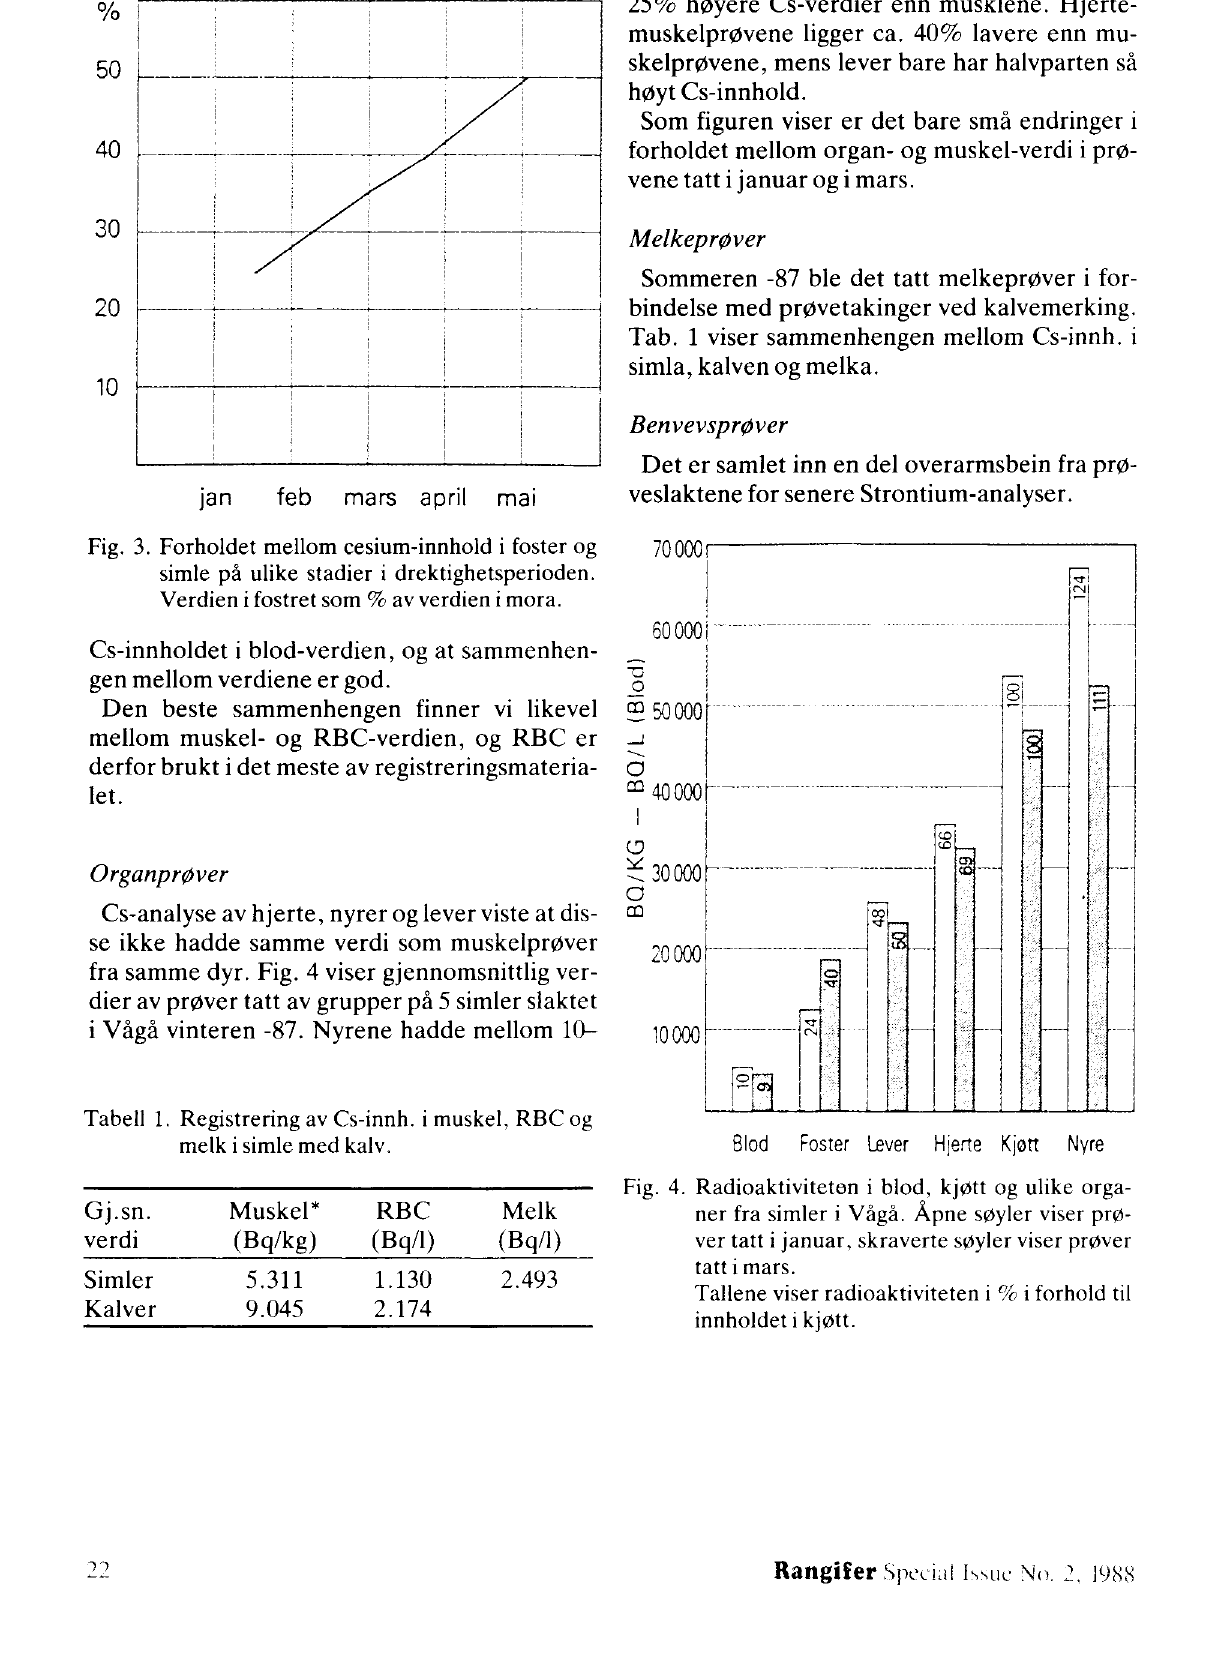
Fig. 4. Radioaktiviteten i blod, kjøtt og ulike orga ner fra simler i Vågå. Åpne søyler viser prø ver tatt i januar, skraverte søyler viser prøver tatt i